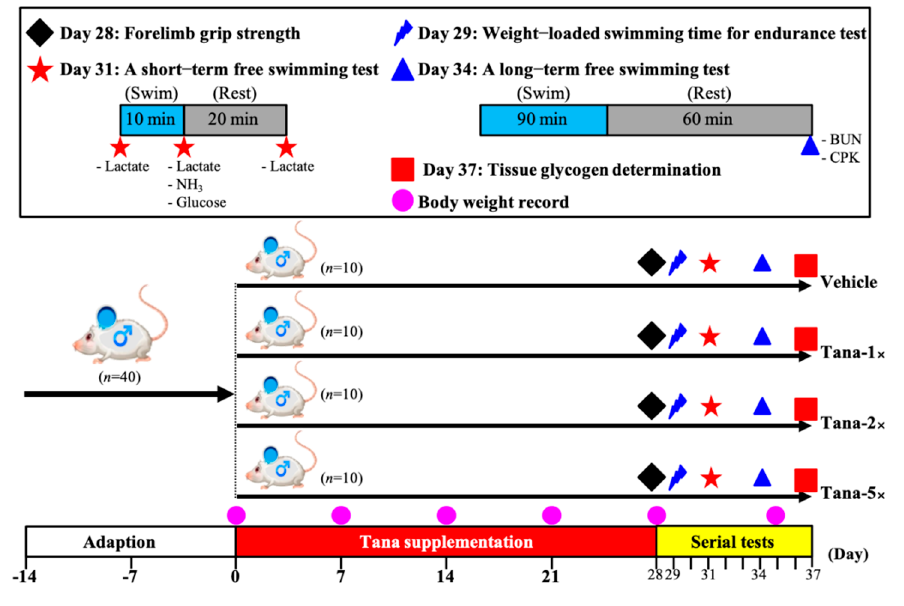
Figure 1. Experimental design.